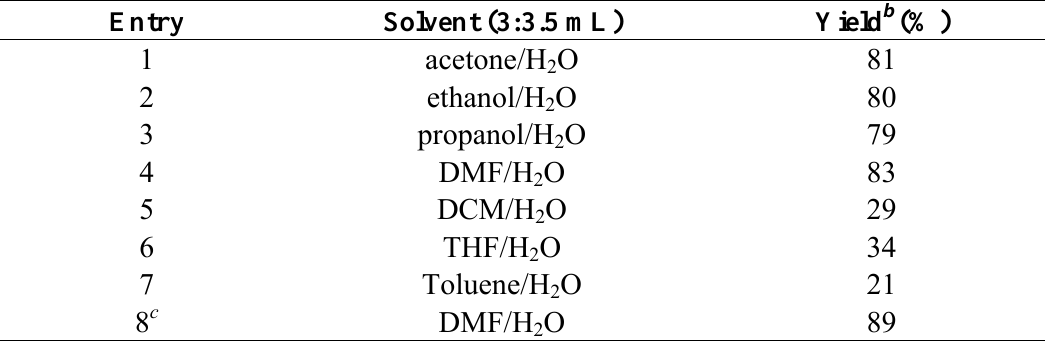
Table 1 Effect of solvent on the Suzuki reaction a .